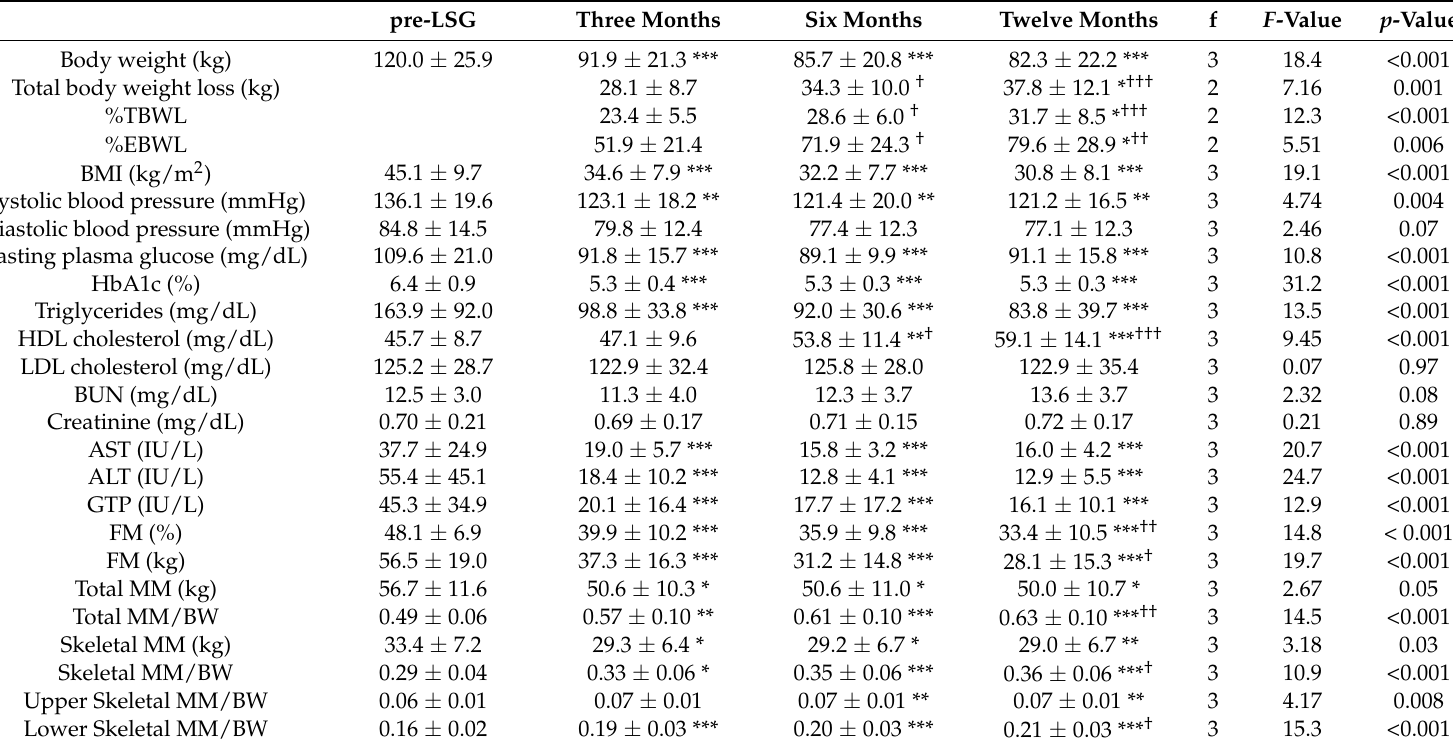
Table 1. Time-course changes in body weight, plasma metabolic parameters, and body